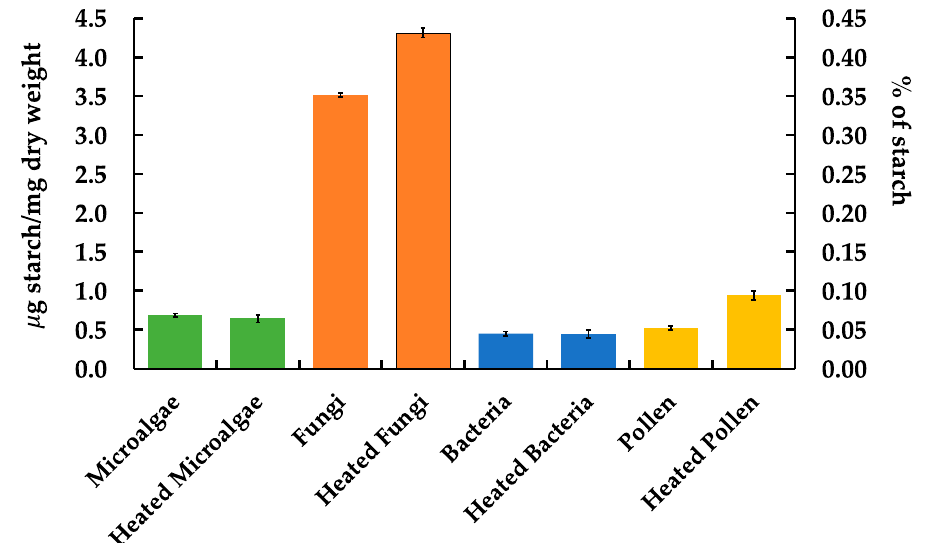
Figure 3. Concentration of starch per milligram of dry weight of selected bioaerosols on the primary axis, with standard deviations. Standard deviations were calculated based on three separate replicates prepared from the same pre-heated pollen stock sample. Percentage of starch of dry weight is found on the secondary axis.